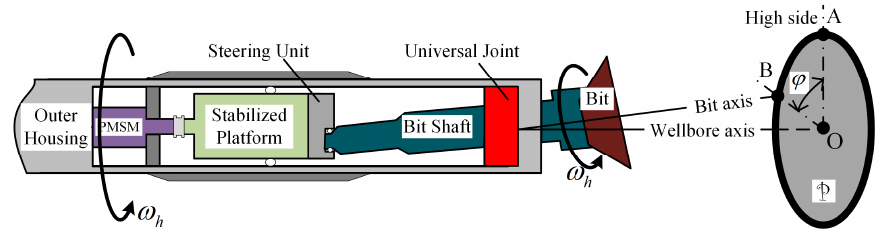
Figure 3. Structural schematic of the DPRSS .